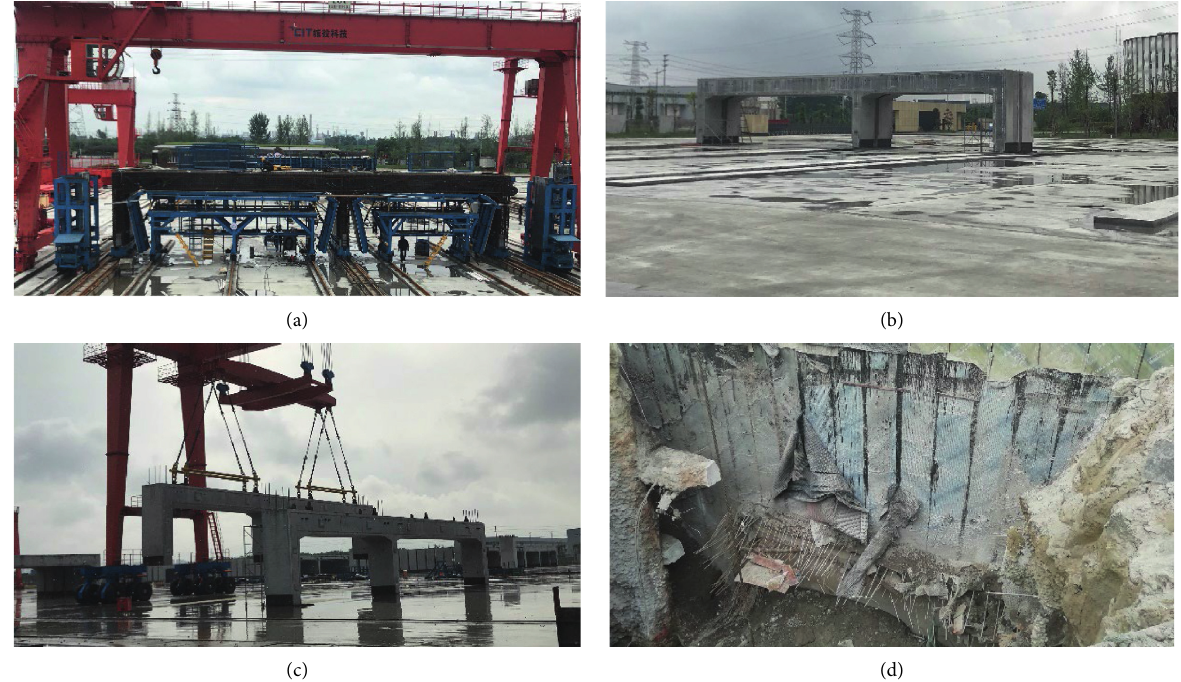
Figure 8: Prefabrication of the segments and construction of the trench: (a) segments mold, (b) prefabricated segments, (c) segment layout, and (d) trench excavation and